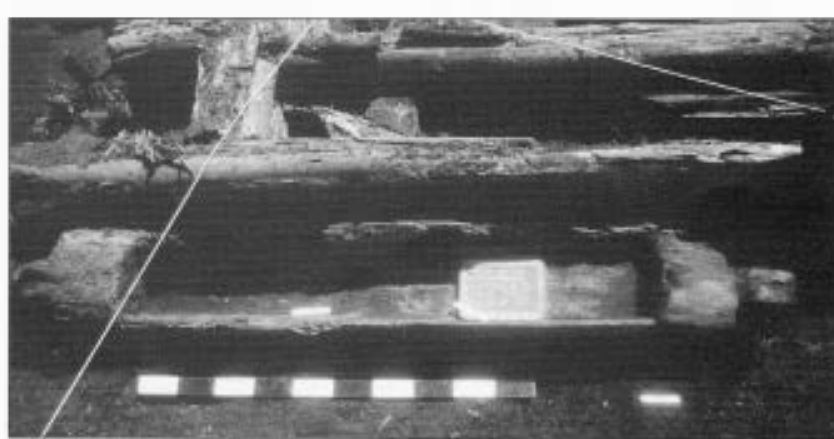
A mid-tenth-century watering trough found in an alley to the east of the exca­ vated building in Troitsky XI (scale bar intervals 10cm).